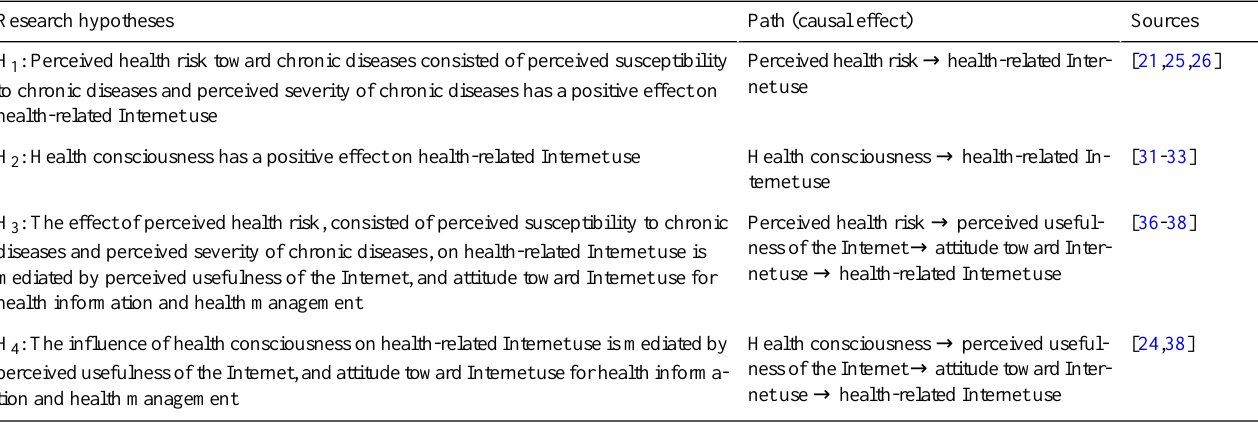
Table 1. Research hypotheses for explaining health-related Internet use drawing upon the Health Belief Model and the Technology Acceptance Model.